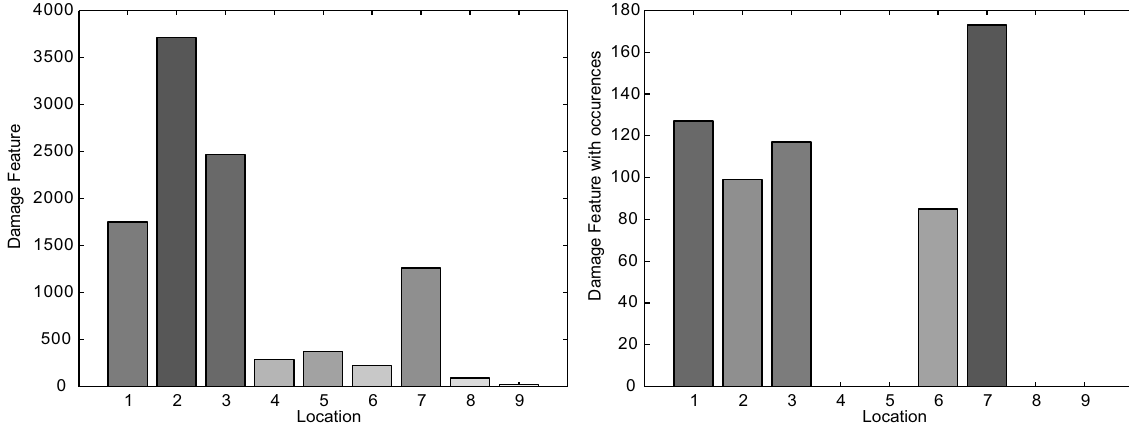
Fig. 10. Damage feature without and with occurrences for undamaged structure and changing loading conditions, frequency range 60–120 Hz.